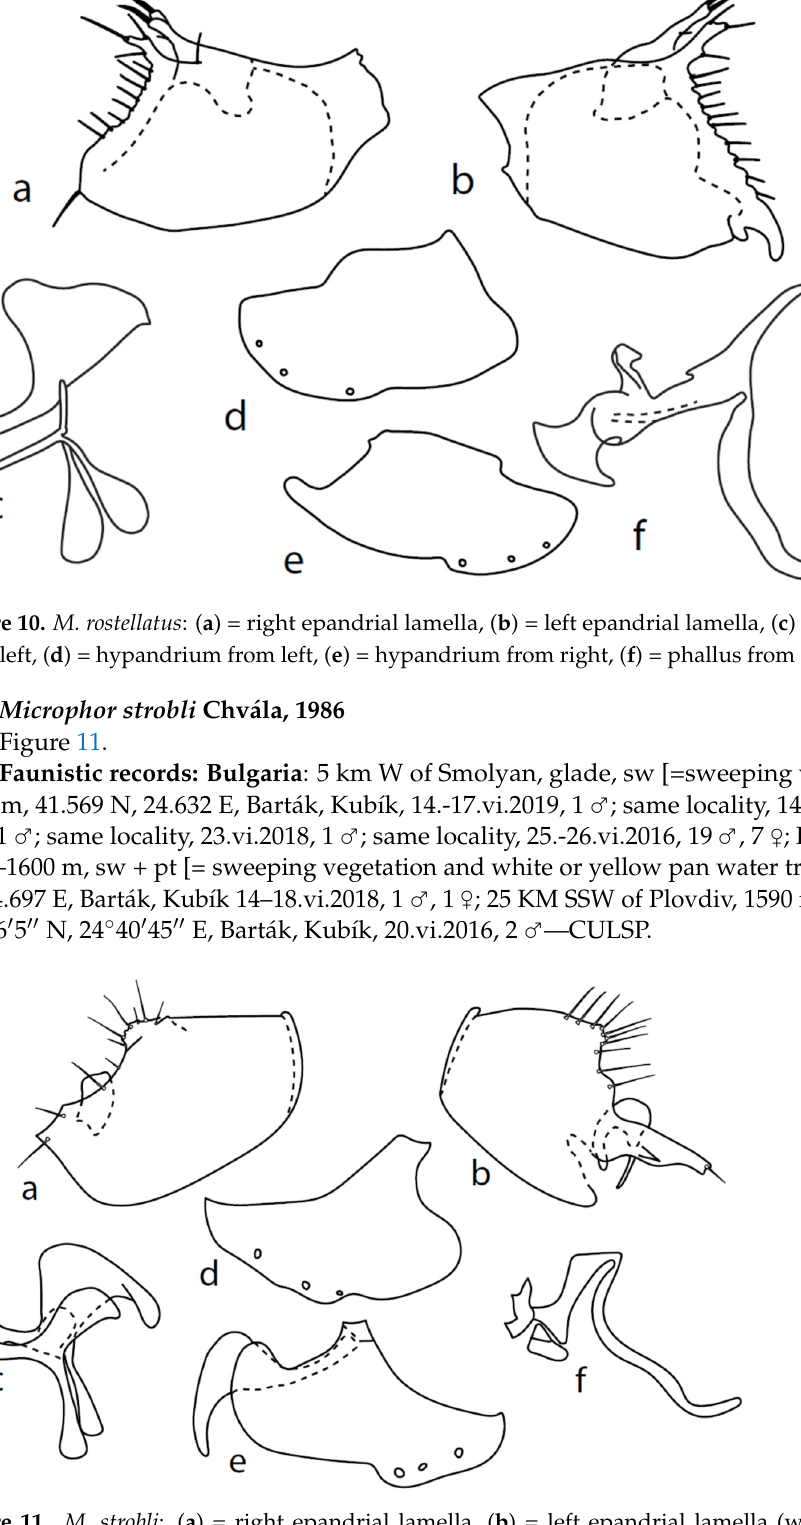
Figure 11. M. strobli : ( a ) = right epandrial lamella, ( b ) = left epandrial lamella (with enlarged middle postgonite lobe), ( c ) = postgonite from left (left ventral postgonite lobe strongly developed), ( d ) = hypandrium from left, ( e ) = hypandrium from right (right dorsal postgonite lobe attached to right apicodorsal lobe of hypandrium), ( f ) = phallus from